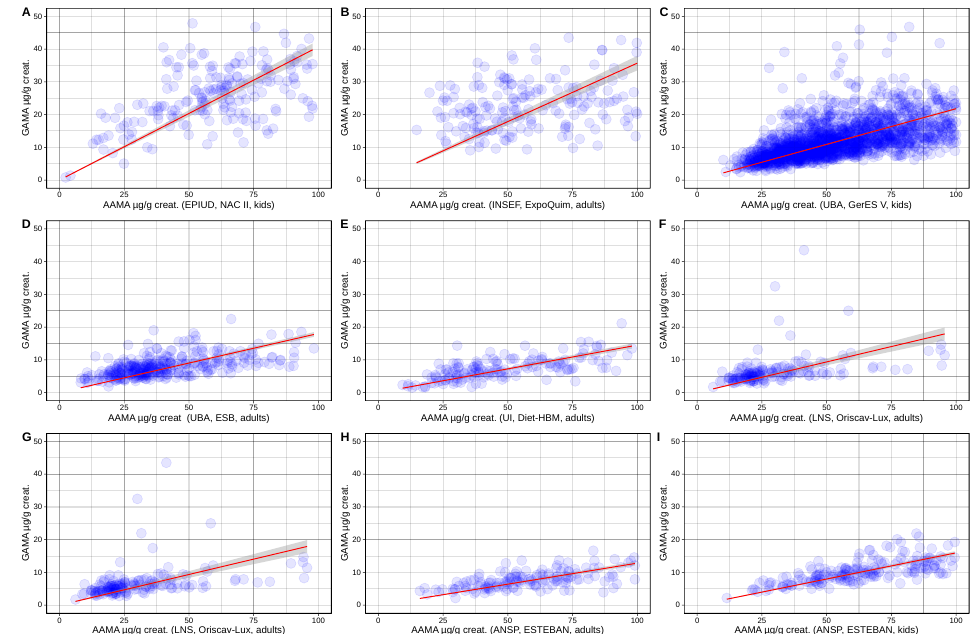
Figure A1. Plots of AAMA vs. GAMA (in µg/L), in 9 different European populations (( A – I ), individual data) as indicated. Linear fit in red, gray = 95%. AAMA to GAMA correlation is